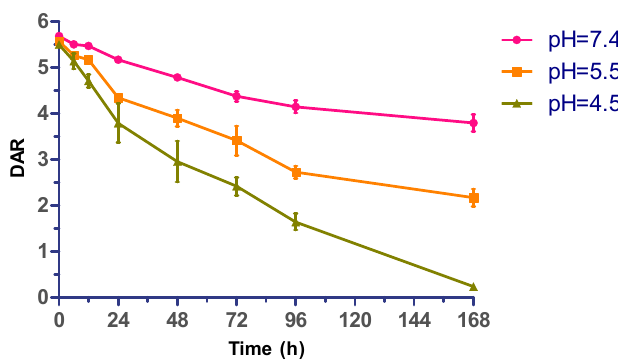
Figure 4. pH-dependent drug release of acid-sensitive ADC (mil40-6). Typical time course of MMAE cleaved from ADC in PBS that pH 7.4, pH 5.5, and pH 4.5. Error bars represent standard deviation from three independent experiments (triplicates). Data are shown as mean ± SD. DAR: drug/antibody ratio.